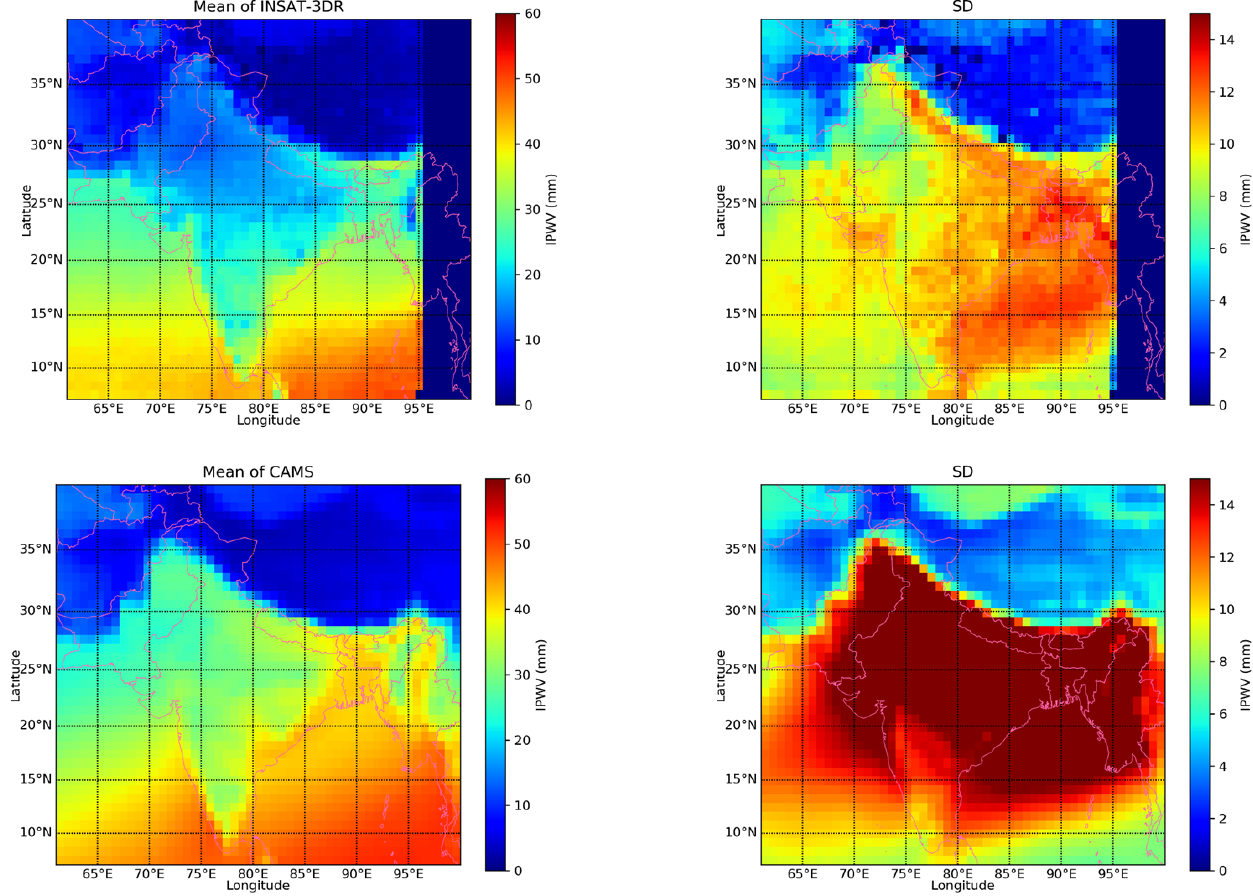
Figure 9. Means and SD of INSAT-3DR and CAMS IPWV for the year